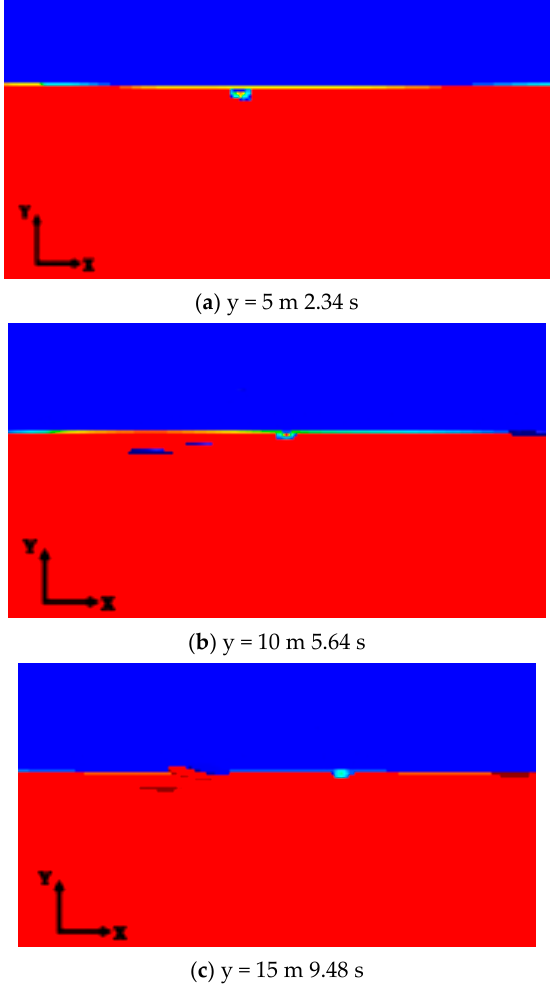
Figure 8. Three-phase distribution of oil–water–air for icy waters at the oil emerging time.